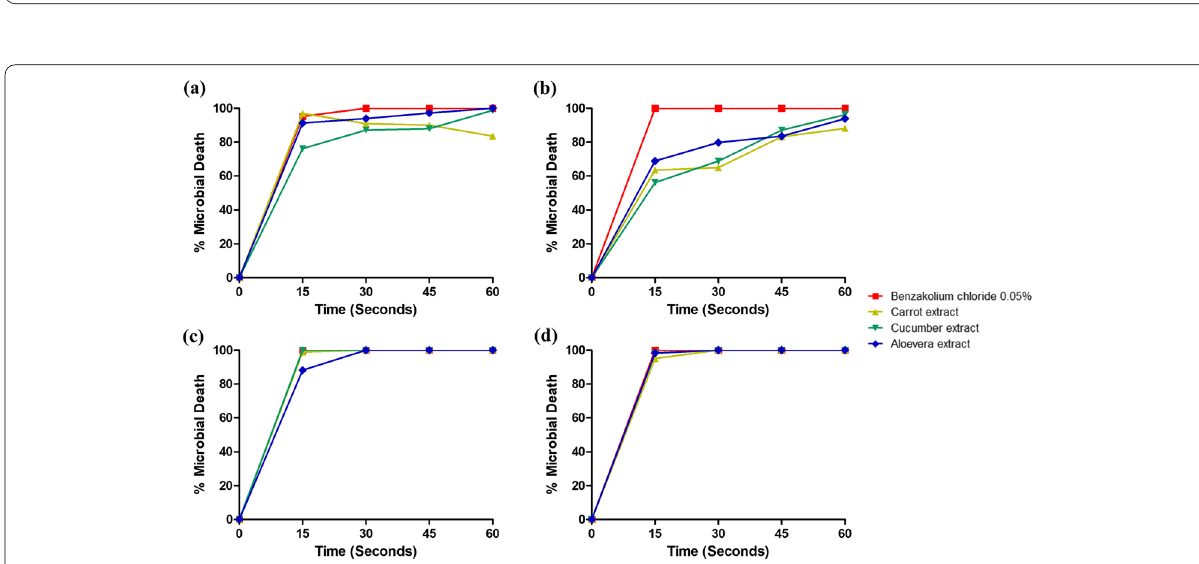
Fig. 2 The effects of varying electrolyte concentration on the percentage microbial death (mean solutions a 85% ethanol (ET), S. aureus ; b 85% isopropyl alcohol (IPA), S. aureus ; c 85% ethanol (ET), E. coli ; and d 85% isopropyl alcohol (IPA), E. coli . N 3 =